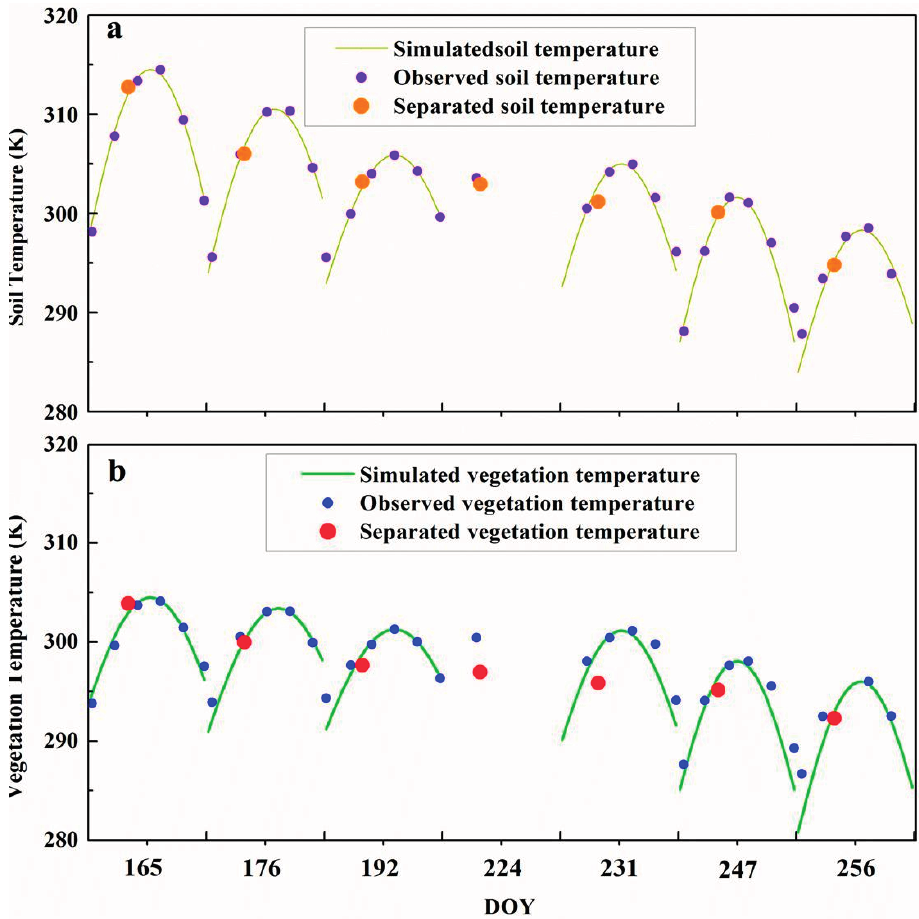
Figure 6. The interpolation of daytime surface soil temperatures ( a ) and vegetation temperatures ( b ) validated with the observed